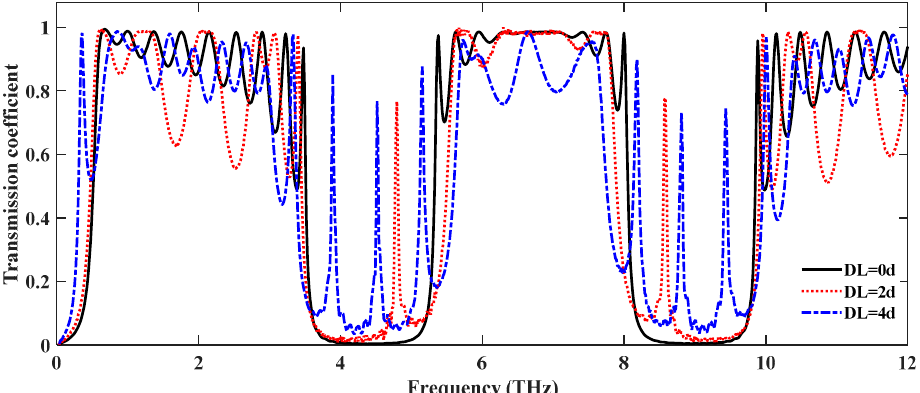
Figure 9. Comparison of the transmission curves and defect modes of 1D plasma PhCs with DL = 0, 2 d , and 4 d . The plasma has the properties of ω p = 2.0 THz, ϑ c = 50